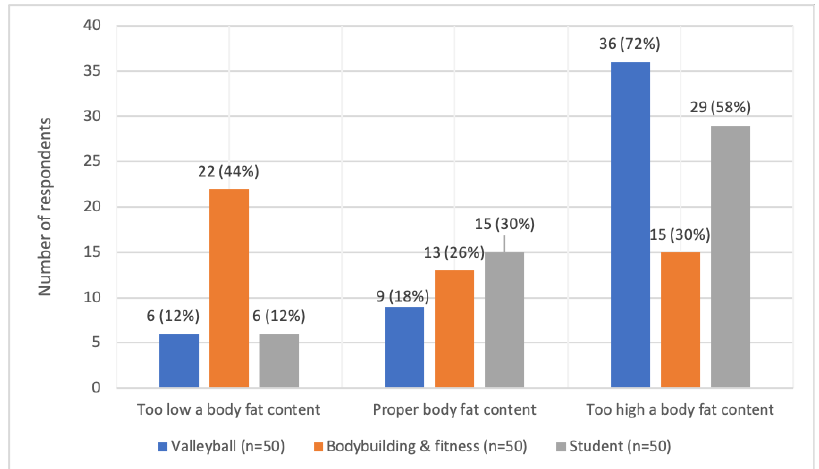
Figure 4. Subjective assessment of the propriety of body fat in the study groups.